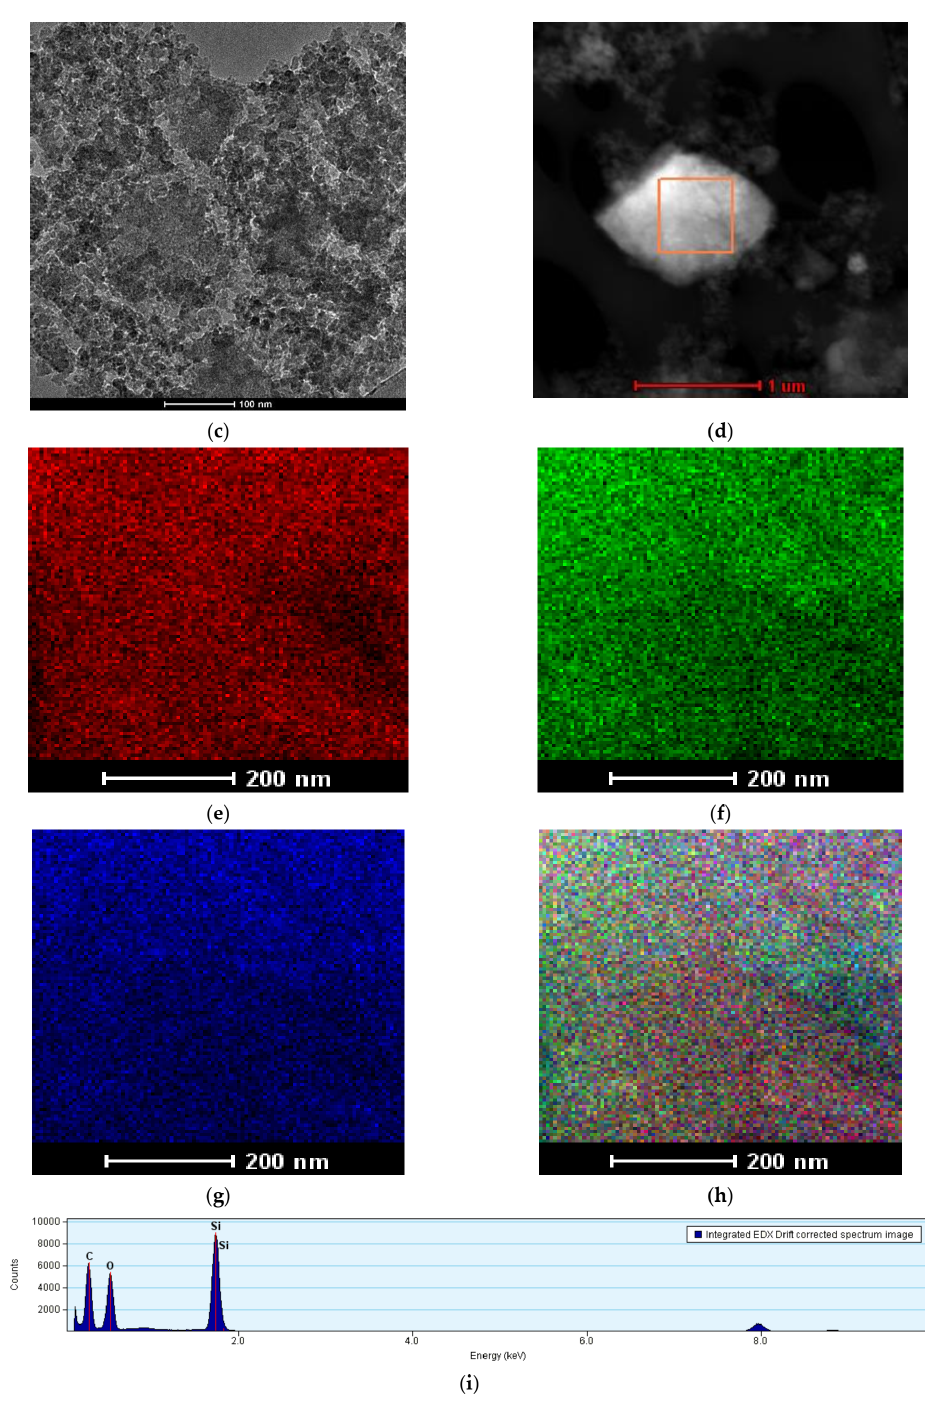
Figure 2. ( a – b ) SEM and ( c – d ) TEM images of C/SiO 2 composite as well as TEM maps of ( e ) carbon, ( f ) silicon, ( g ) oxygen, ( h ) composite and ( i ) integrated EDX drift corrected